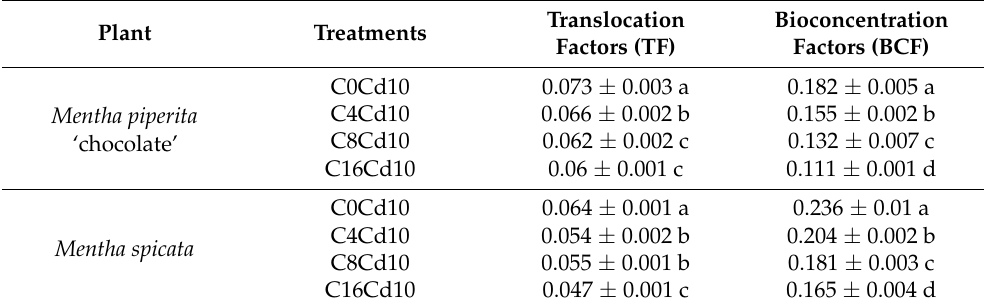
Table 5. Effect of biochar application on the TF and BCF of two mint species under Cd contamination.